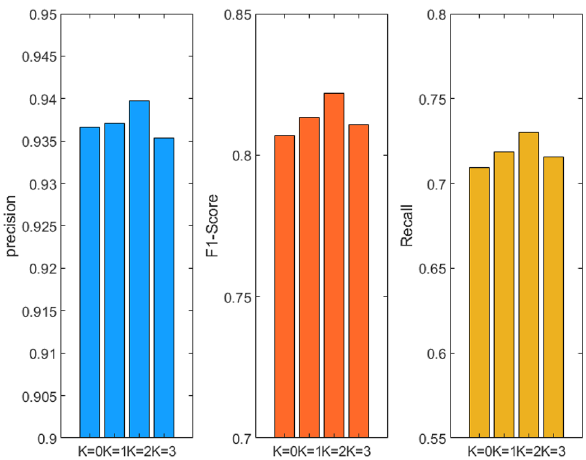
Figure 5. Visualization results of data enhancement methods.